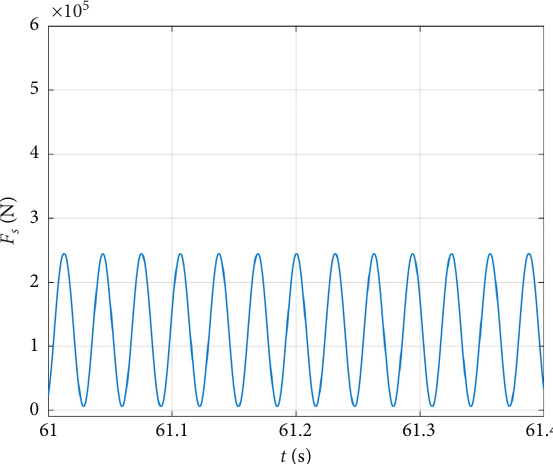
Figure 4: The contact forces F